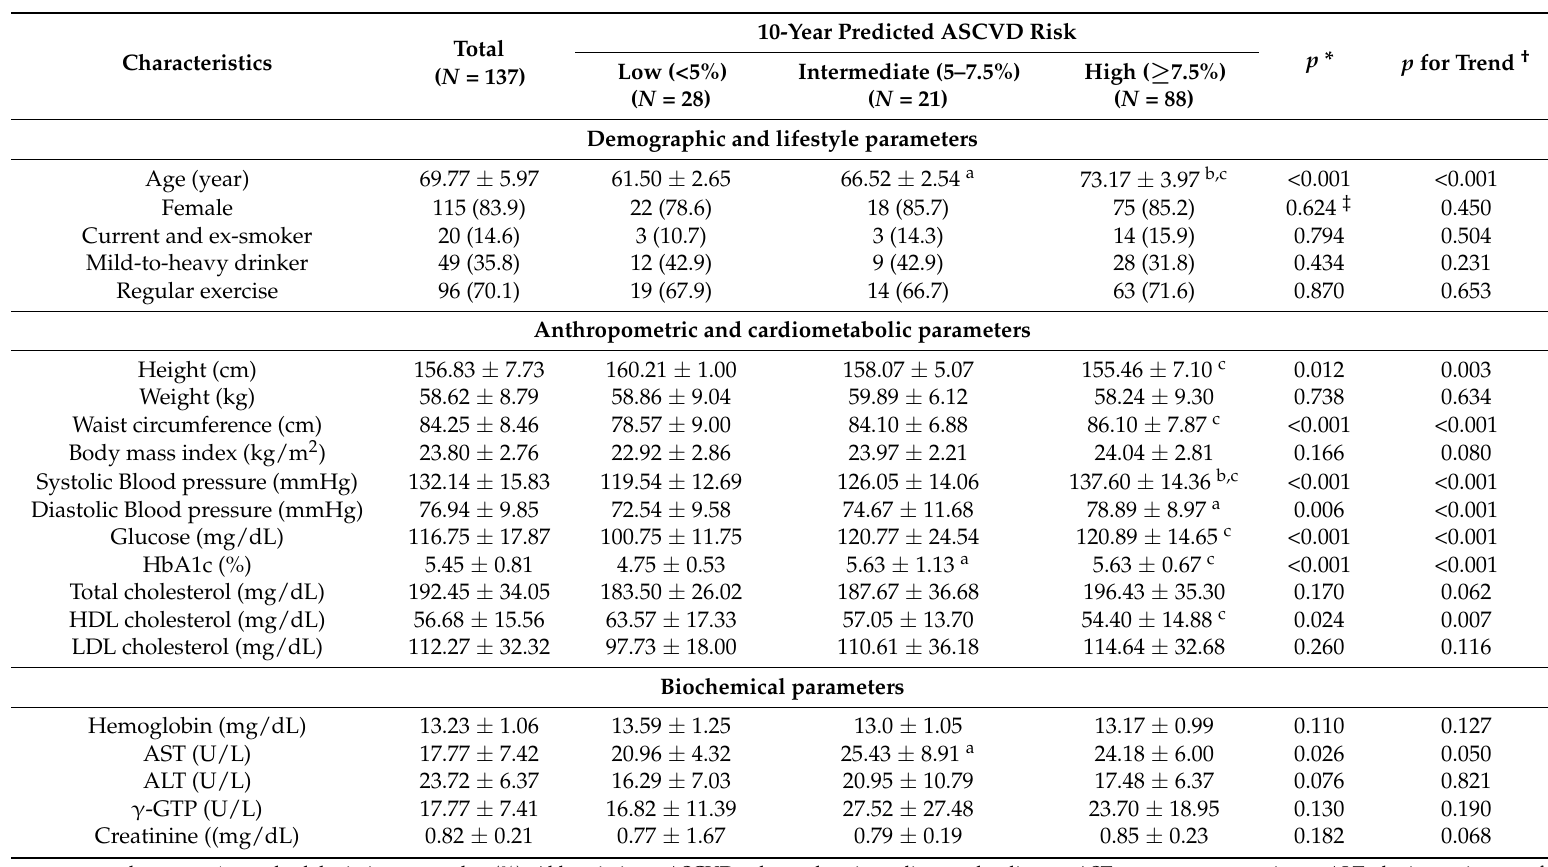
Table 1. Baseline characteristics of the three groups of subjects stratified by the severity of ASCVD